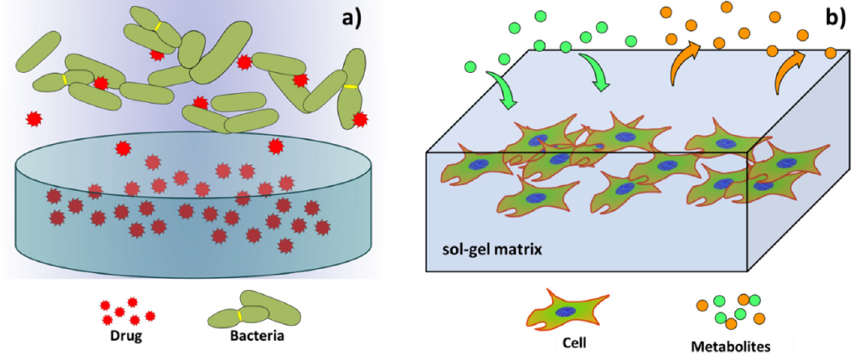
Figure 16. ( a ) Schematics of a sol-gel matrix loaded with antibiotic drugs for the treatment of localized bacterial infections. ( b ) Schematics of a cell culture embedded in a porous sol-gel matrix for tissue engineering applications.